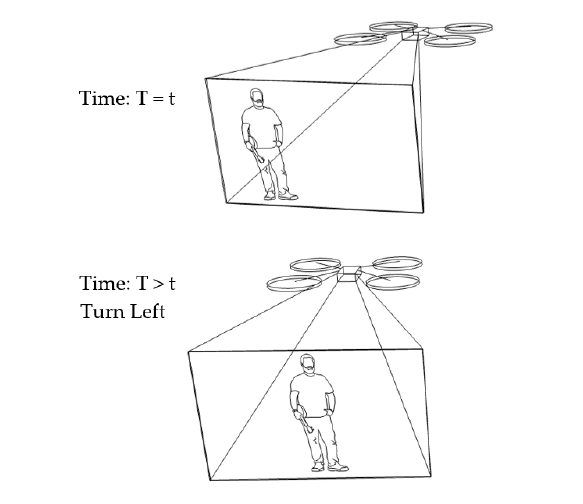
Figure 7. Human motion tracking when the drone turns left.